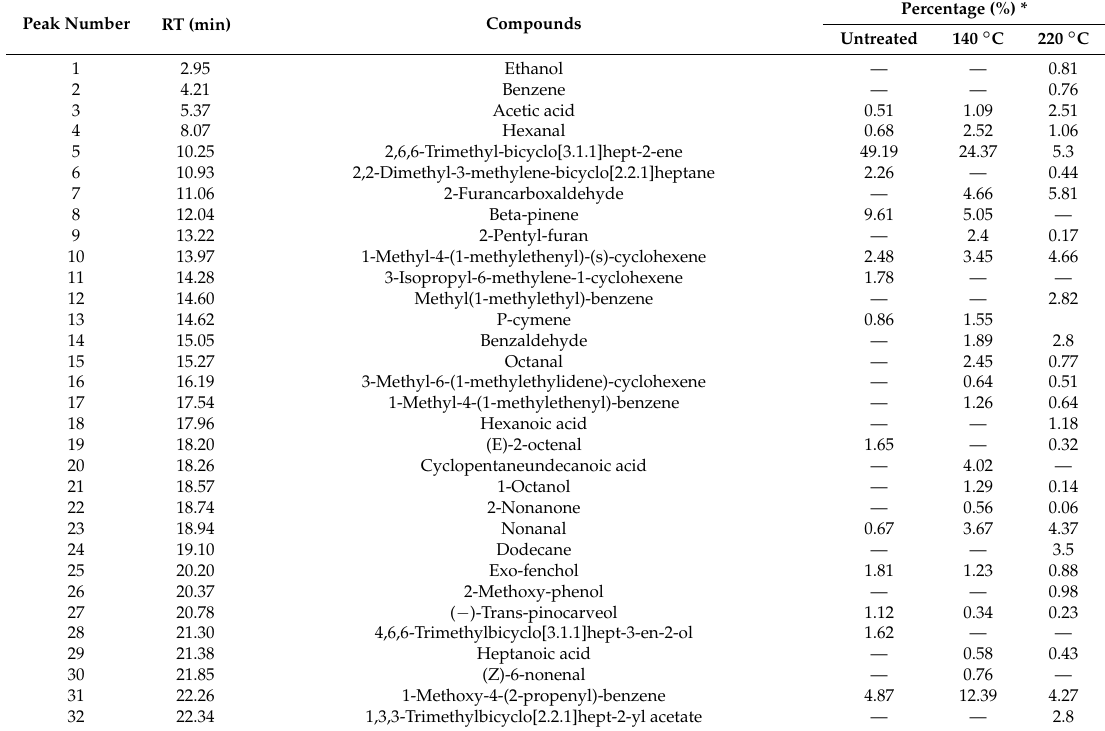
Table 4. Comparison of volatile organic compound (VOC) content in untreated southern pine (SP) and heat-treated